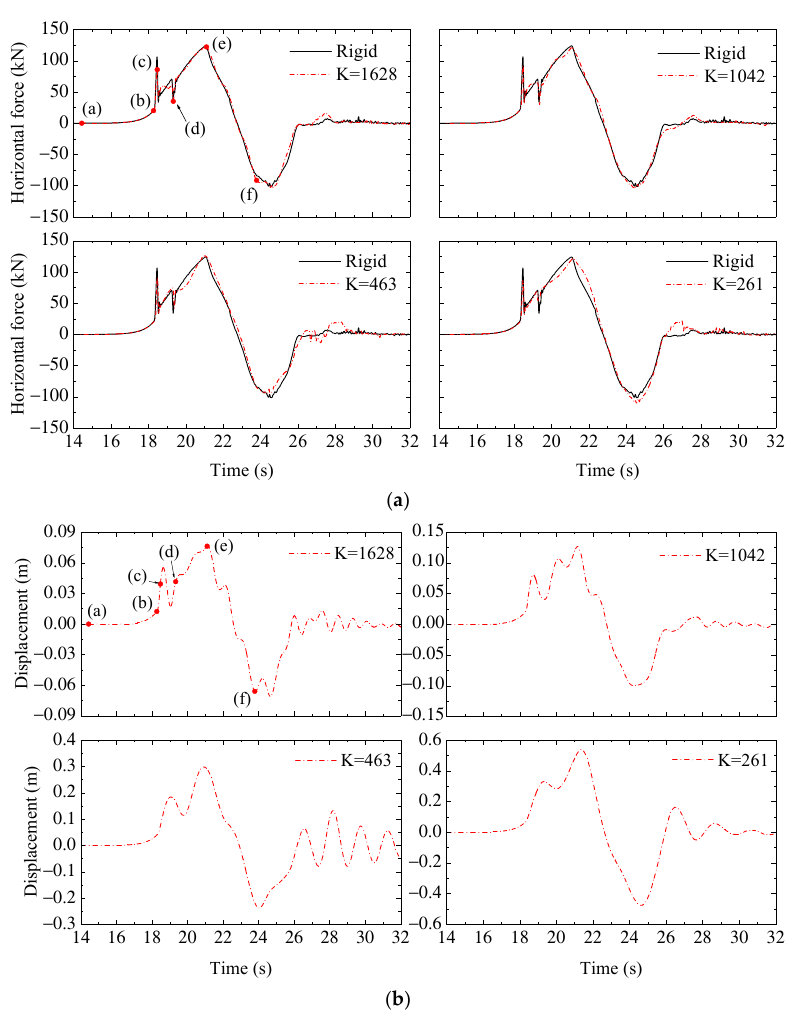
Figure 16. Comparison of different restraining stiffnesses for E20/Cs (0), in which, letters (a–f) correspond to the moment of 14.40 s, 18.24 s, 18.48 s, 19.32 s, 21.00 s, and 24.36 s. ( a ) Comparison of the time theories of horizontal force; ( b ) Comparison of the time theories of